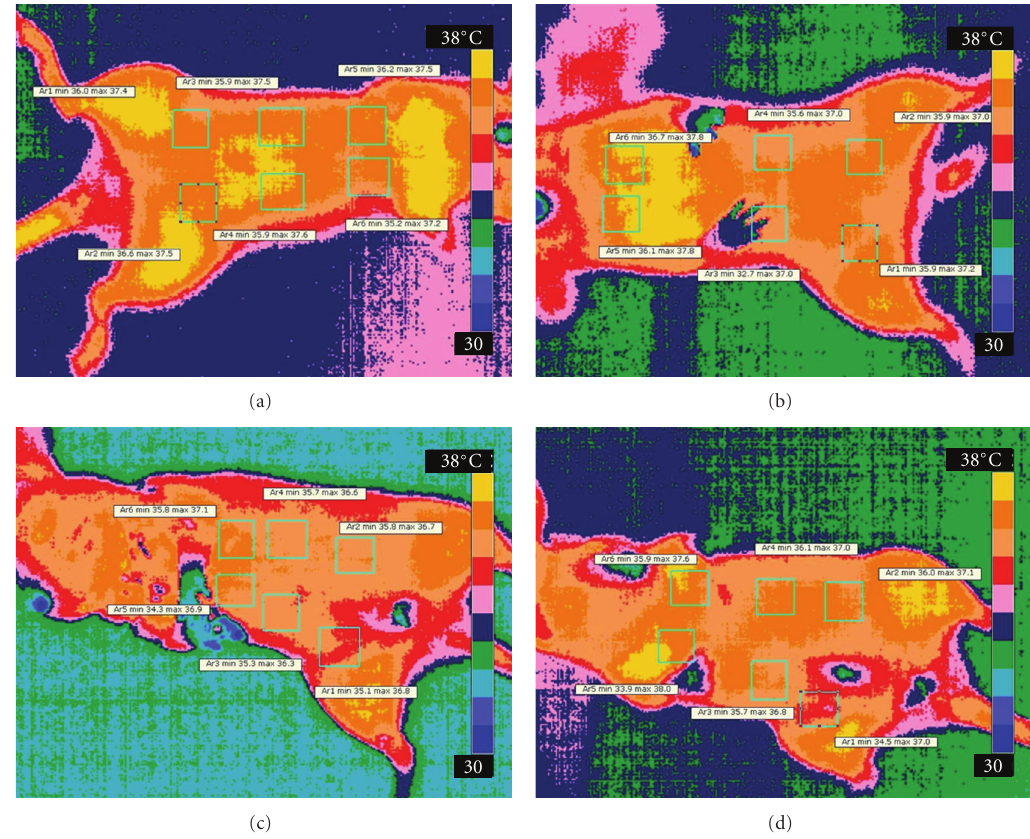
Figure 3: Whole body digital infrared images of a single rat taken on di ff erent weeks ((a) week 1, (b), week 2, (c) week 3, and (d) week 4) after tumor cancer induction by DMBA which show the tumor growth by color change from thick orange (a), then light orange (b), then red color(c), and then to red color with pink center in the fourth week indicating a reduction in skin temperature